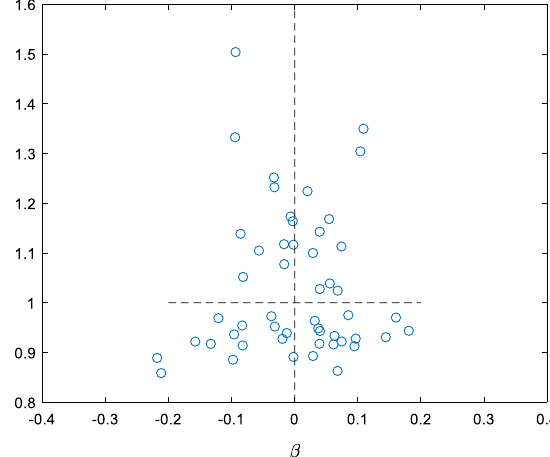
Fig. 1 α and β values of redistributed signal with various transform p